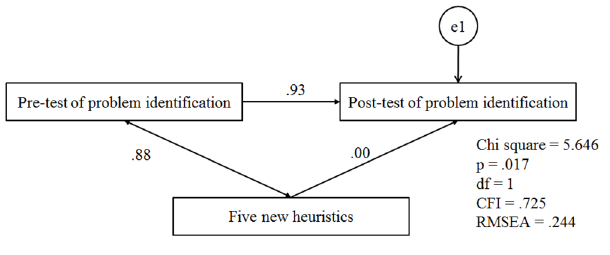
Fig 11. Analysed model when a = 0.